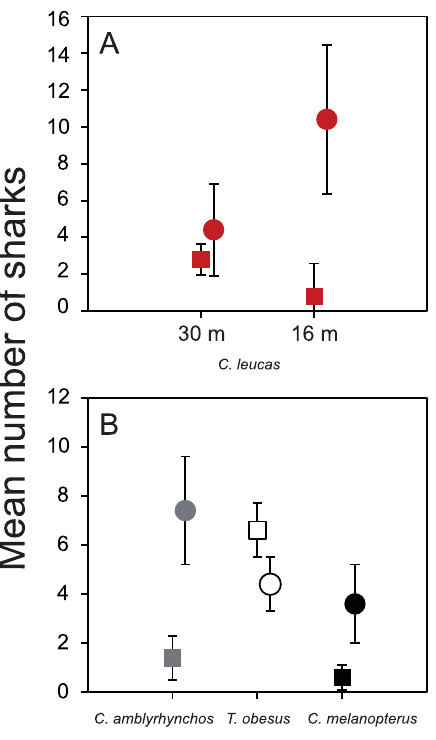
Figure 6. Mean number of sharks counted on feeding and non- feeding dives in March 2008. (A) Mean ( 6 SD) number of C. leucas counted at the 30 m feeding site and at the 16 m feeding site, and (B) mean ( 6 SD) numbers of C. amblyrhynchos , T. obesus and C. melanopterus counted at the shallow (5–10 m) feeding site. Circles denote sampling days on which sharks were offered food and rectangles denote non-feeding days.